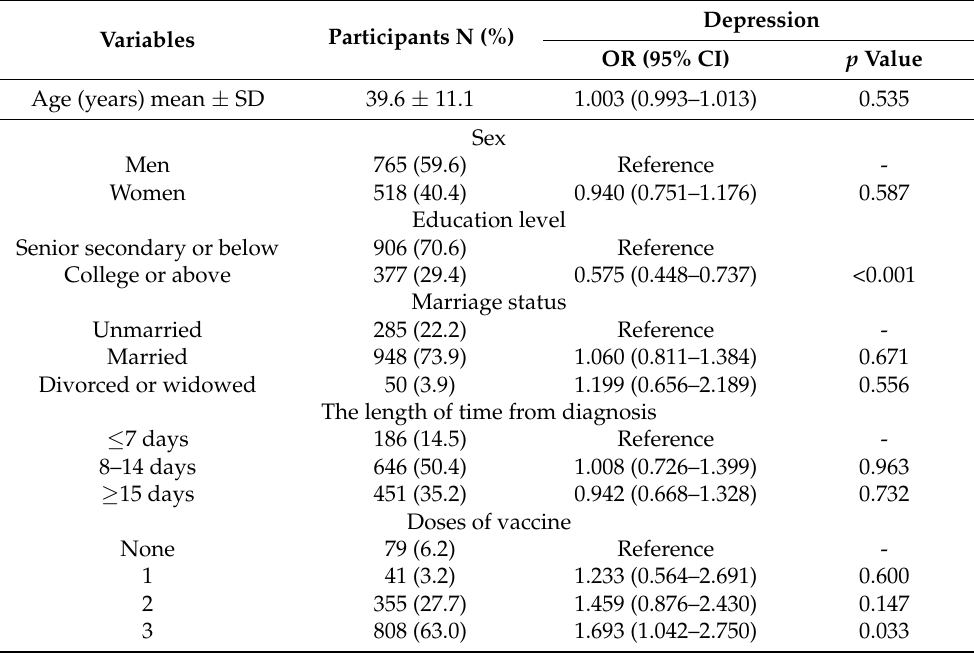
Table 1. Characteristics of asymptomatic COVID-19 carriers and univariate logistic regression analysis of depression ( n = 1283).